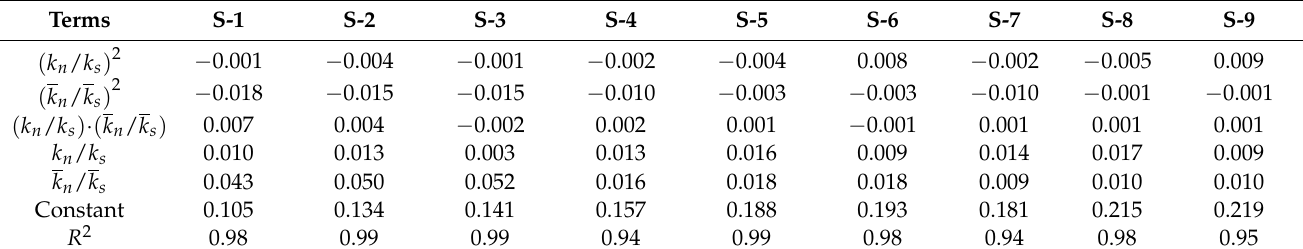
Table 9. Response surface equation of Poisson’s ratio.